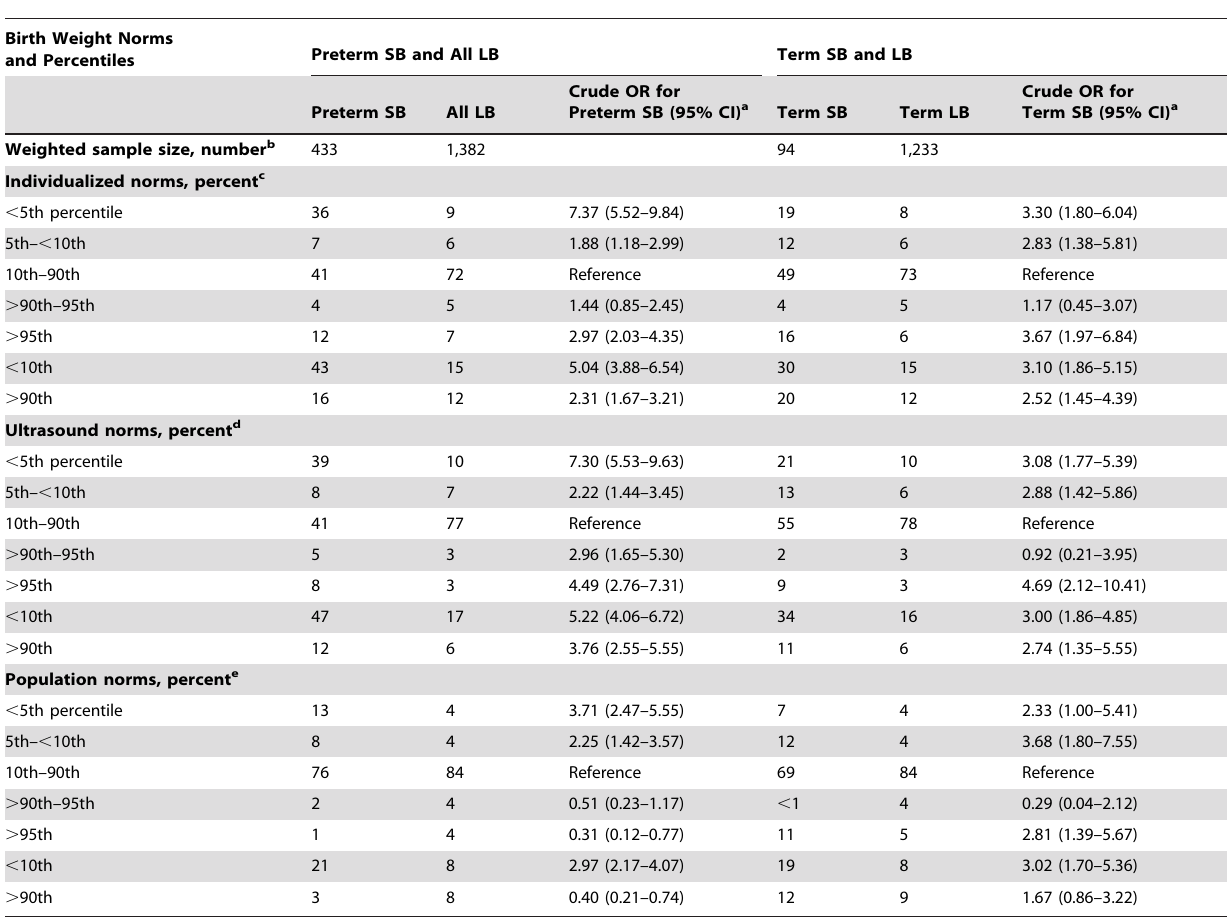
Table 7. Birth weight percentiles among preterm and term stillbirths and live births.